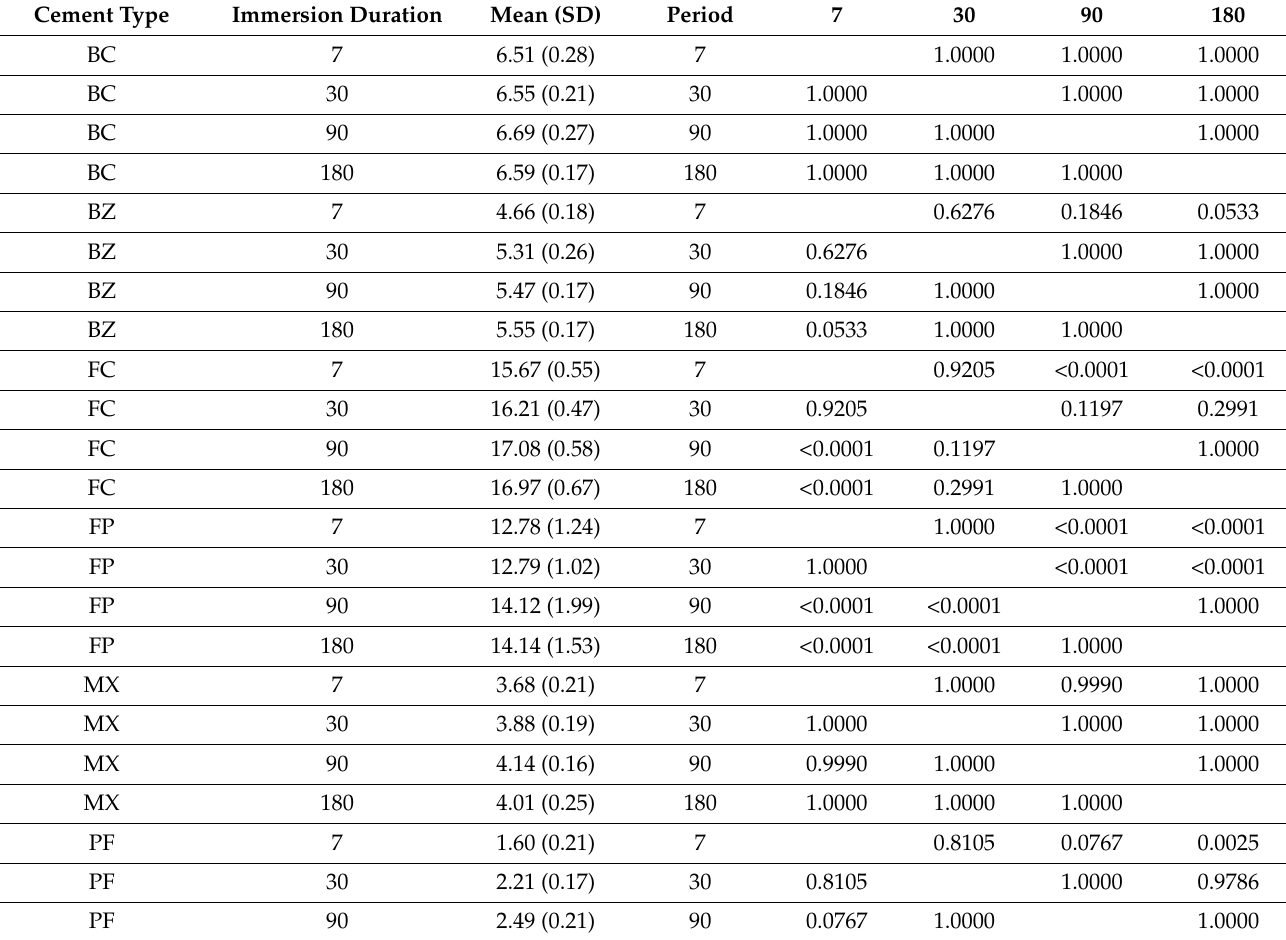
Table 4. Statistical intra group comparison (cement) of WSP (%) among different immersion sub-groups (Pair-wise comparisons within luting agent; Tukey adjusted p